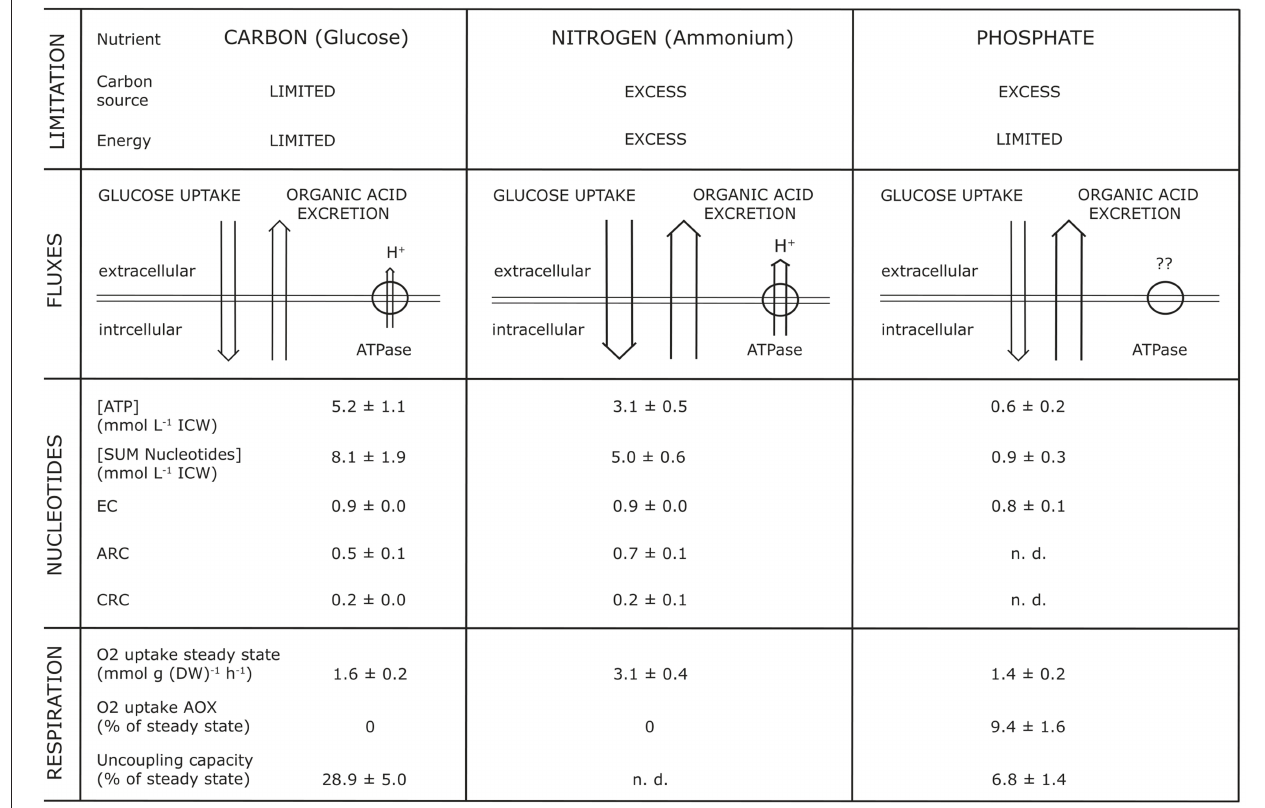
change in the allocation of resources (Basan et al., 2015; Basan,